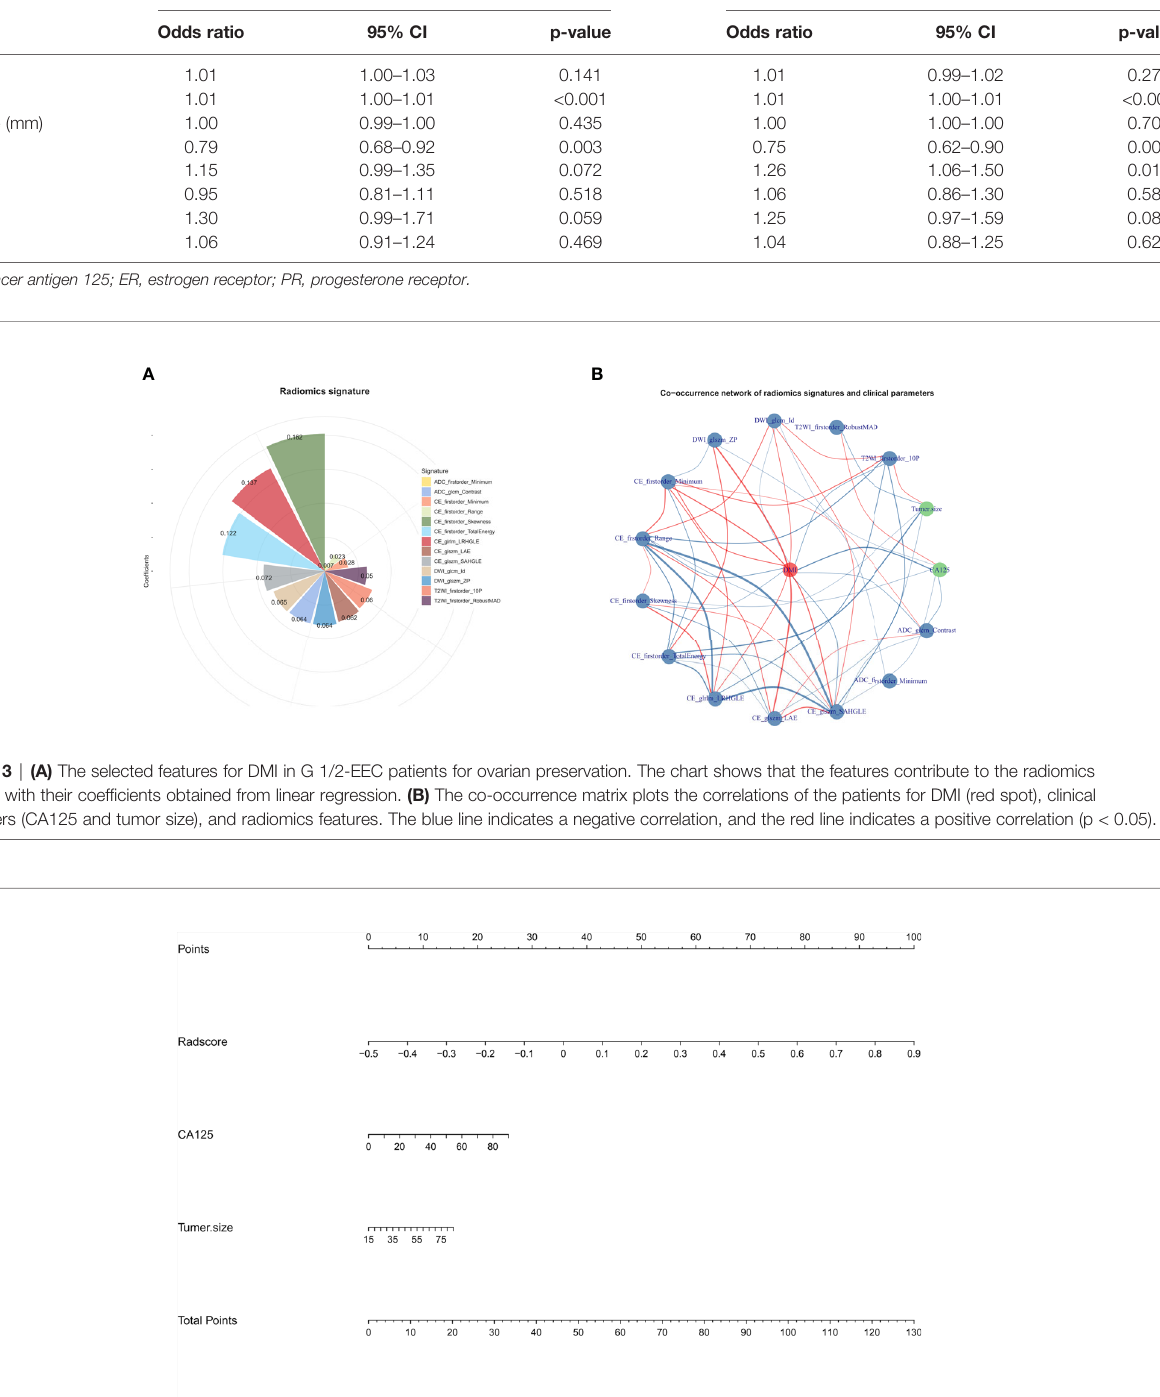
TABLE 2 | The univariate and multivariate logistic regression analyses for independent predictive factors of DMI in patients for ovarian preservation. Variables Univariate analysis Multivariate analysis